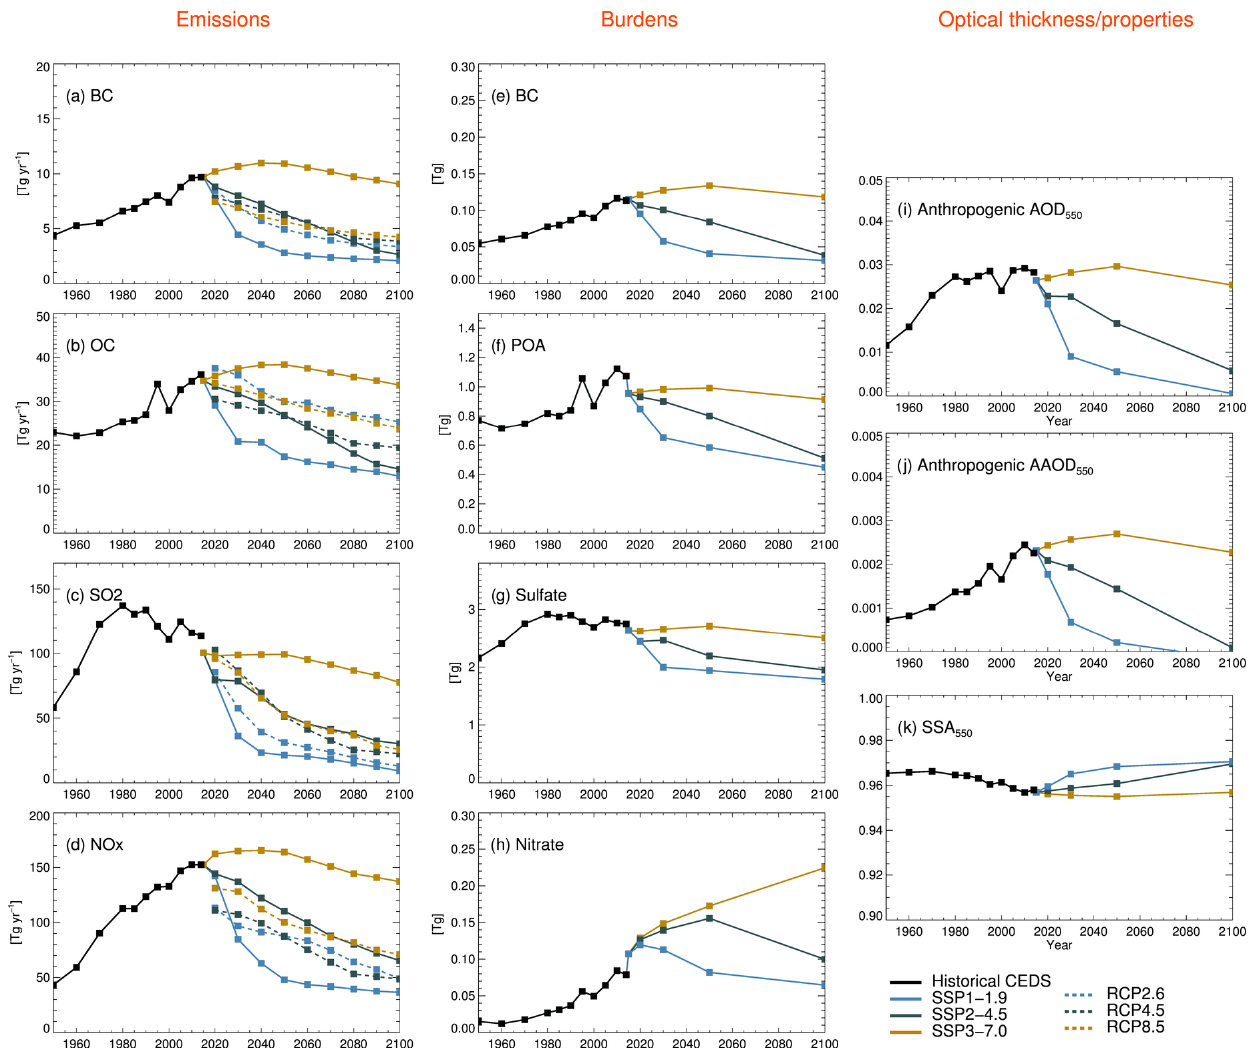
Figure 1. Left: annual global emissions (fossil fuel, biofuel and biomass burning) of BC, OC, SO 2 and NO x over the period 1950 to 2100 from the CEDS historical inventory and SSP1-1.9, SSP2-4.5 and SSP3-7.0 (solid colored lines). Emissions from RCP2.6, RCP4.5 and RCP8.5 (dashed lines) are added for comparison. Middle: modeled total global burdens of BC, POA, sulfate and fine-mode nitrate. Right: anthropogenic AOD and AAOD, and total (anthropogenic and natural) SSA at